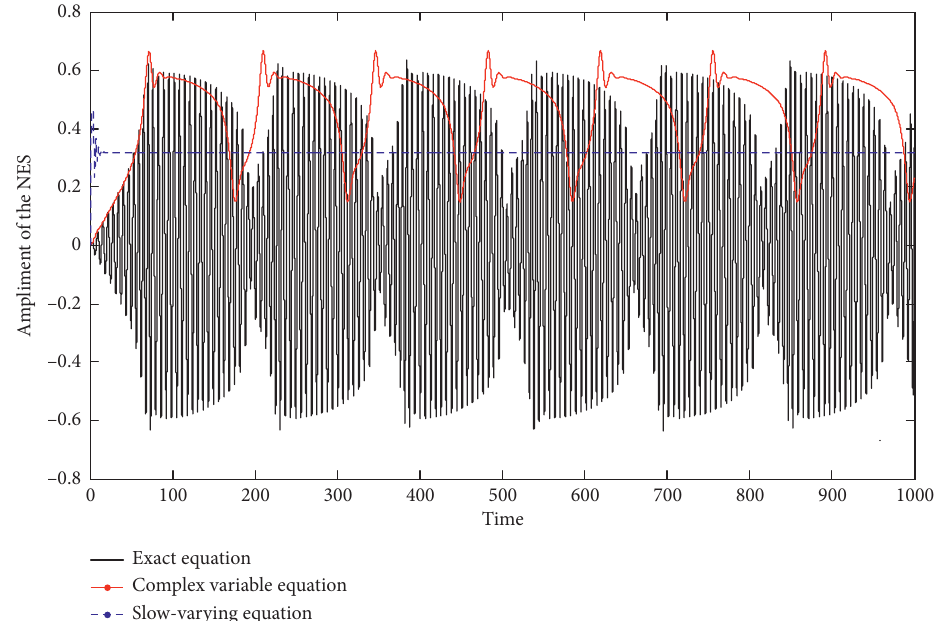
Figure 17: Time-history curves of nonlinear energy sink. The dashed line refers to the steady-state response of the slow-varying equation ( f � 0 . 6).